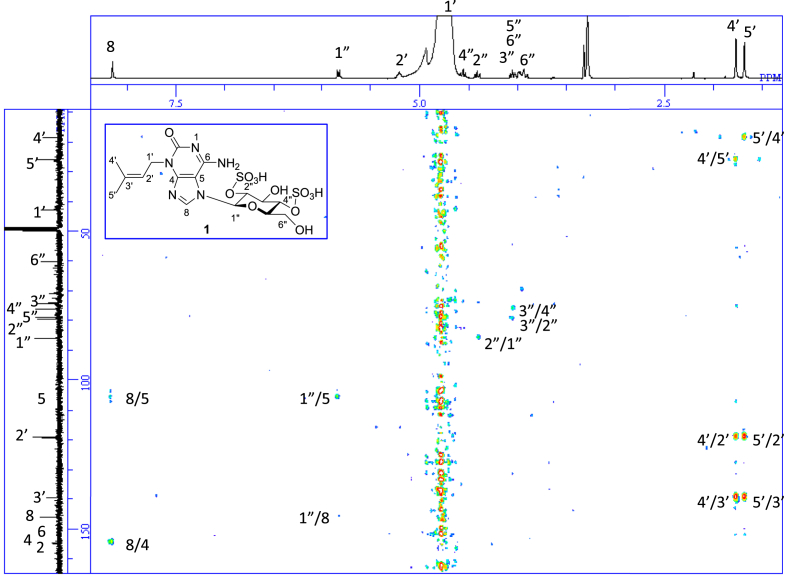
1H–13C HMBC of 1.